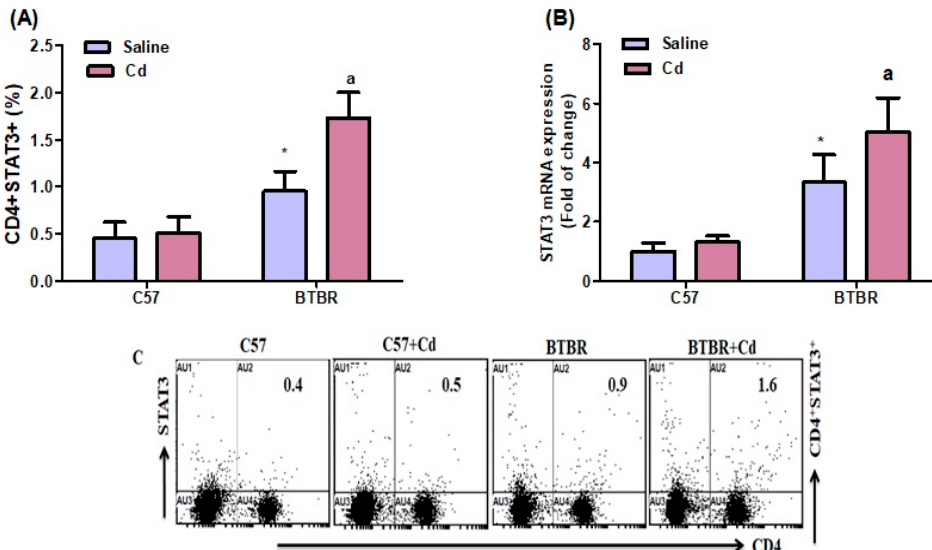
Figure 5. Effects of oral Cd exposure on STAT3. ( A ) STAT3-expressing CD4 + T cells from the spleen. ( B ) TNF- α mRNA expression in brain tissue. ( C ) Representative FSC-SSC dot plots of CD4 + STAT3 + cells taken from each mouse spleen. BTBR and C57 mice were orally administered Cd (5 mg/kg/day) or saline (control) daily for six weeks. All data are shown as mean ± SD ( n = 6/group). Di ff erent le tt er indicate signi fi cant di ff erence. * p < 0.05 vs. saline-treated C57 mice, ap < 0.05 vs. saline-treated BTBR mice; two-way ANOVA with Tukey’s test.